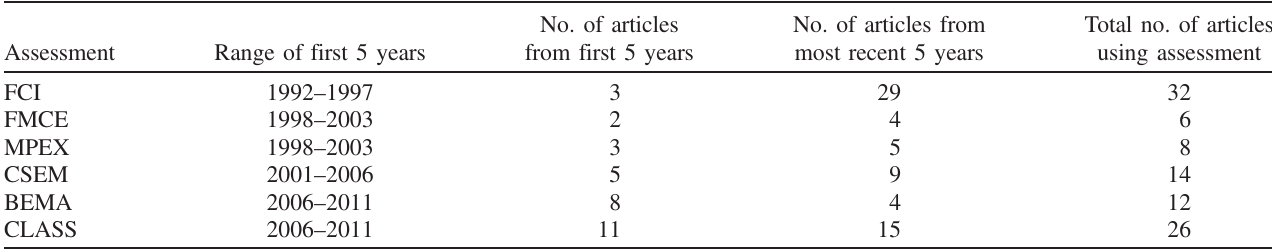
TABLE I. Description of assessments considered for phase